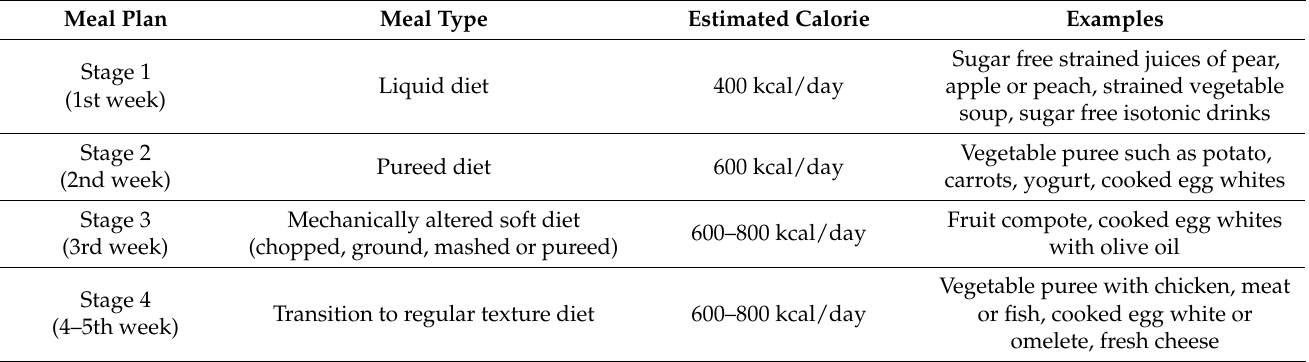
Table 1. Nutrition plan in the immediate phase after endoscopic bariatric